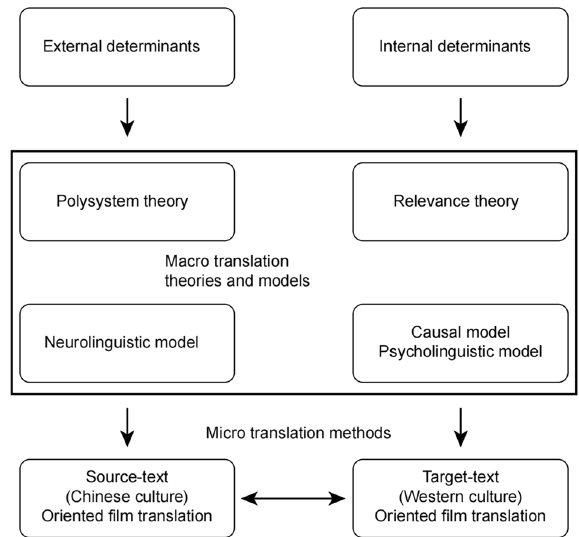
Fig. 1 Conceptual framework used for dubbing Monkey King: Hero is Back (2015). This fi gure demonstrates this study ’ s theoretical macro base and the micro translation method identifying the external and internal factors determining the dubbing strategies used in Monkey King: Hero is Back